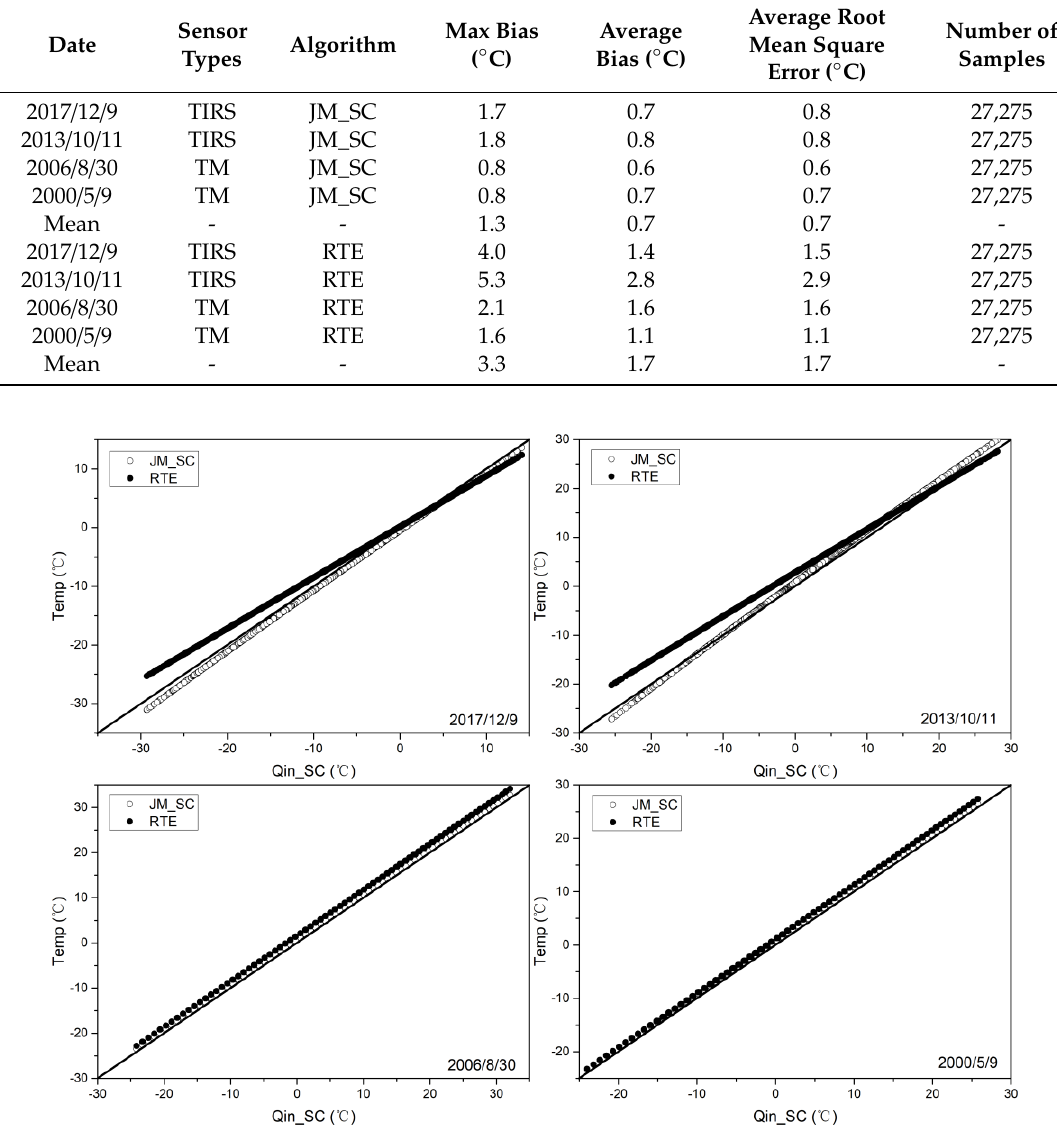
Figure 2. Glacier surface temperatures (GSTs) calculated by the Qin et al.’s single-channel algorithm (Qin_SC) in this paper versus the JM_SC algorithm and radiative transfer equation (RTE).